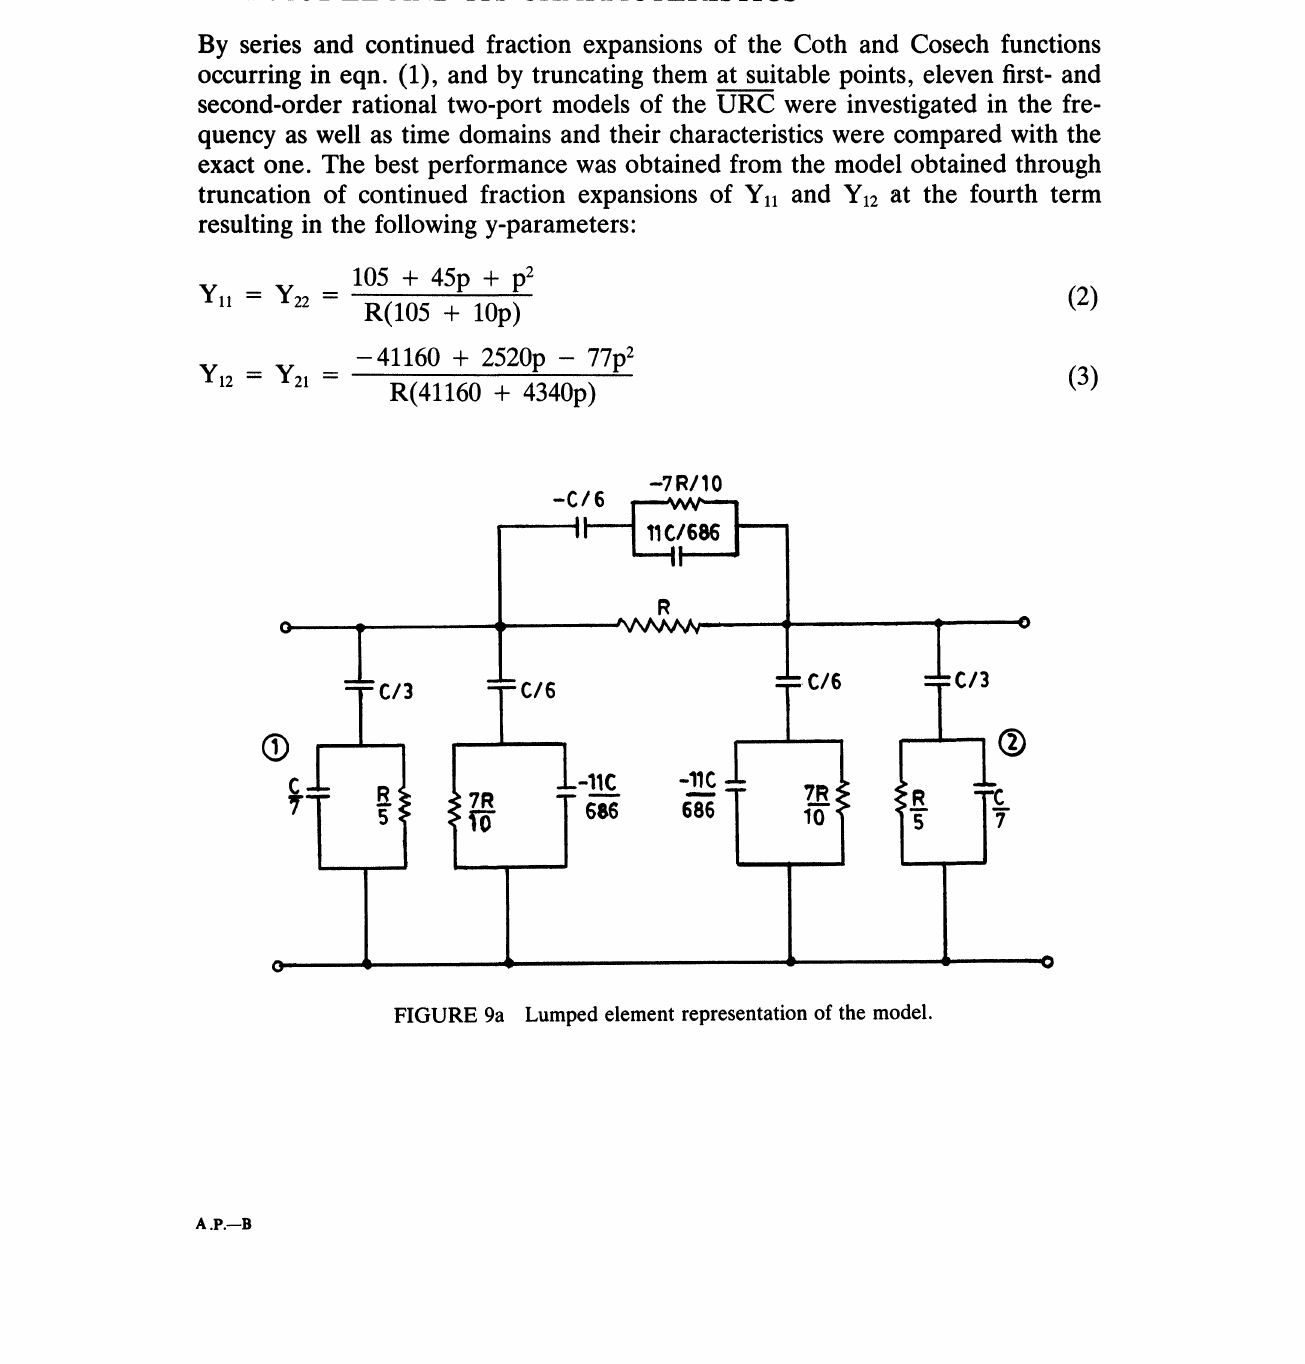
FIGURE 9a Lumped element representation of the